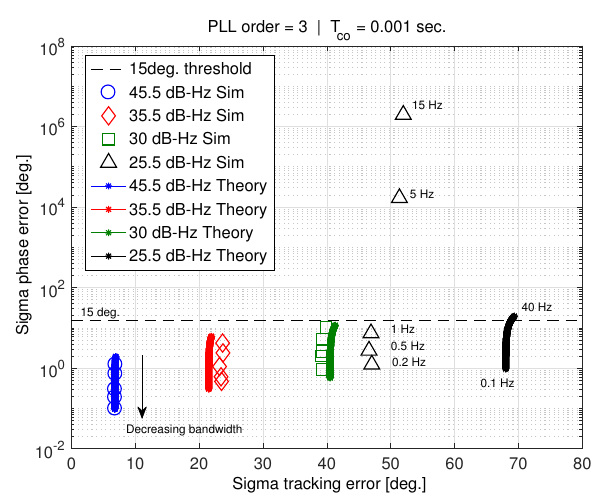
Figure 10. Sigma phase error vs. sigma tracking error.